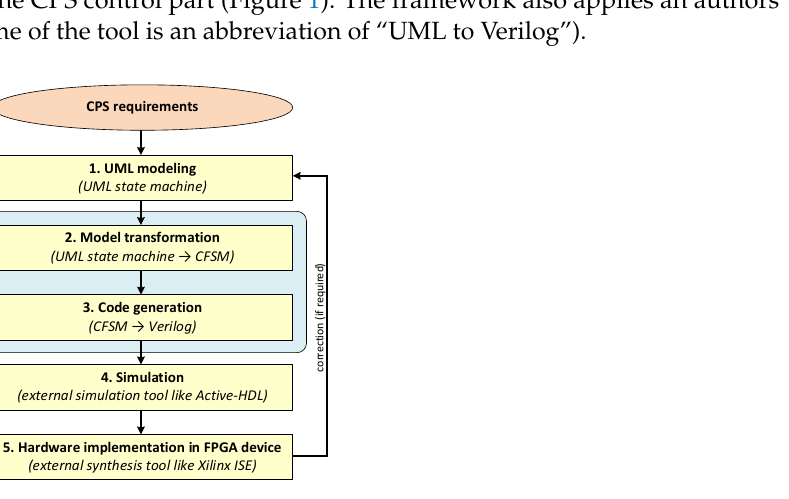
Figure 1. The proposed CPS control part design framework.